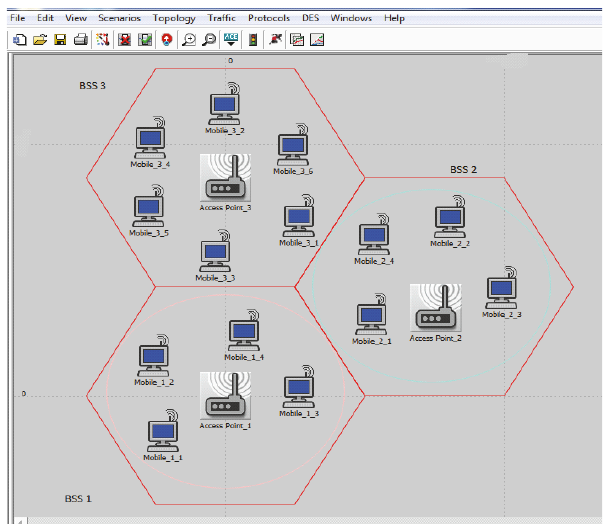
Figure 2: Diagram of the network to be